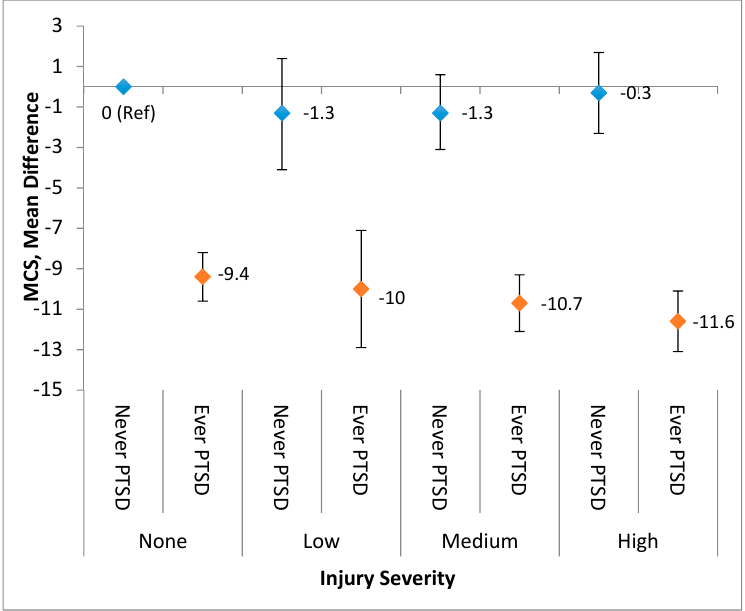
Figure 4. A combination of PTSD history and the injury severity level predicted adjusted regression beta coefficients for MCS-12.